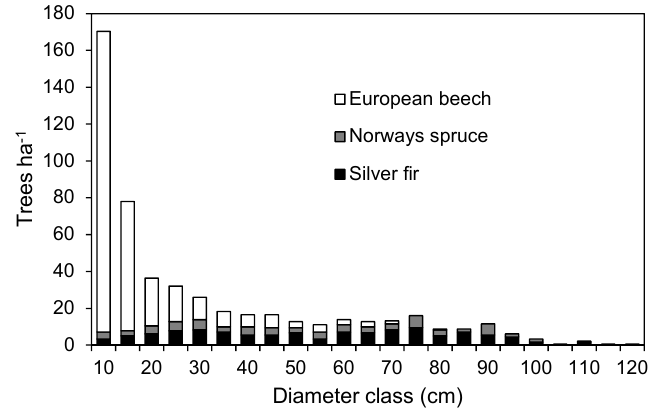
Figure 2. Diameter distribution of living trees in the core area of